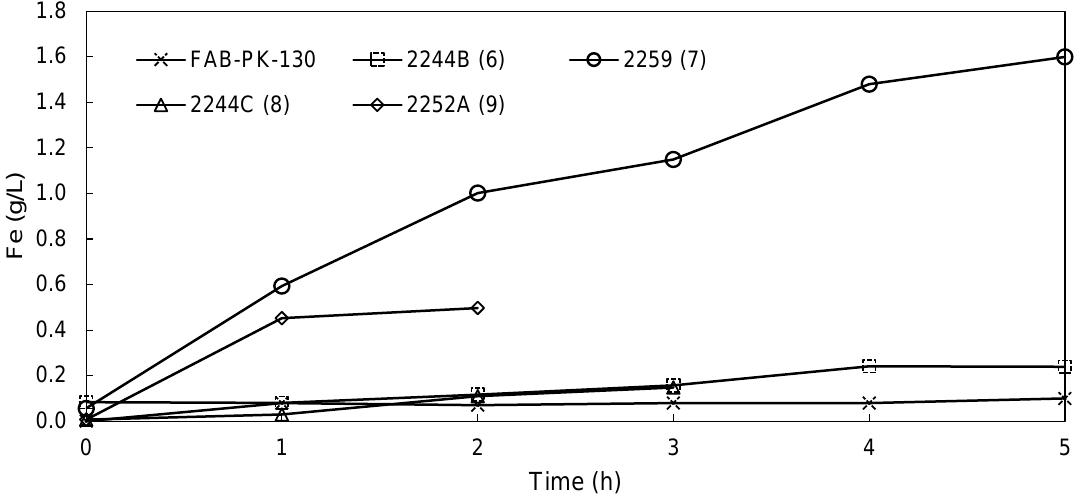
Figure 7. Change in the anolyte Fe content for membranes FAB-PK-130, 2244B (6), 2259 (7), 2244C (8), and 2252 A (9) during EW.